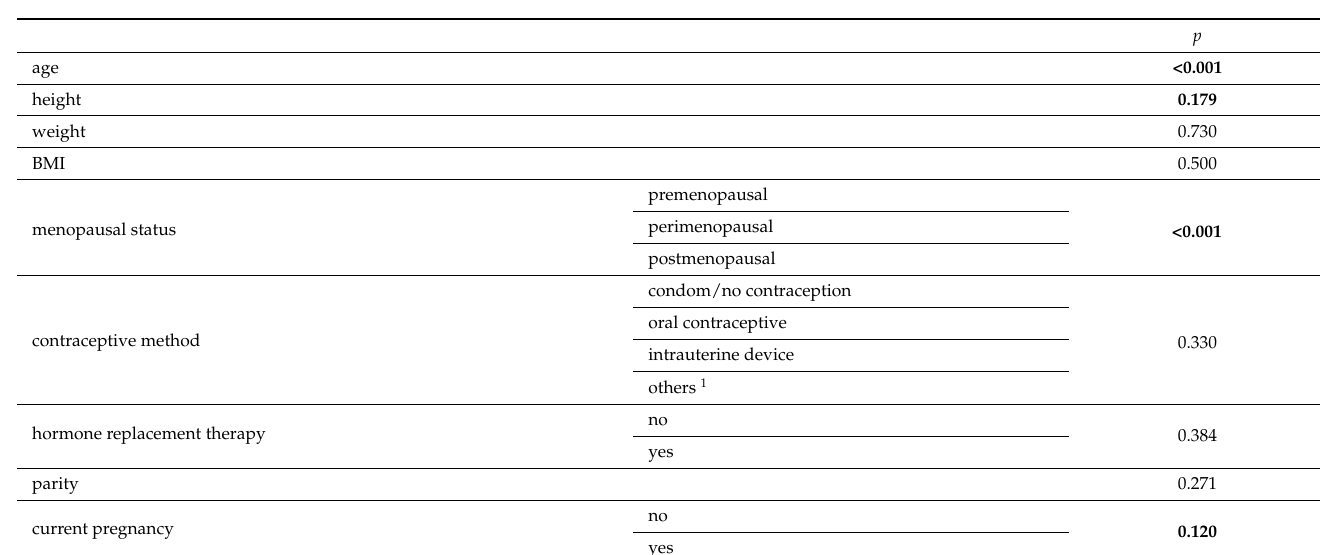
Table 2. Univariate logistic